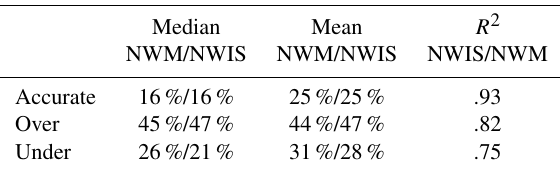
Figure 4. A histogram of area ratios for 54 catchments shows a tendency for the NWM to slightly overpredict flood area and a long right tail of extreme overprediction. Table 3. Mean and median values for NWM and NWIS AOU met- rics and R 2 values for linear fits between NWIS and